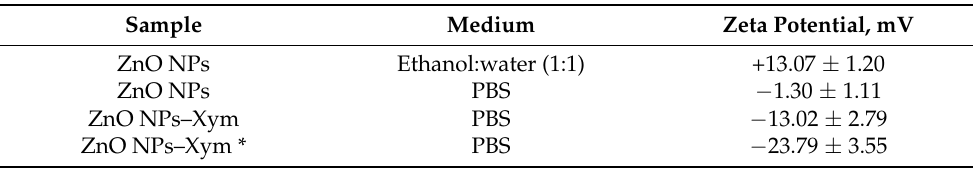
Table 4. Zeta potential of 0.02% ZnO NPs dispersions at pH 7.4. Sample